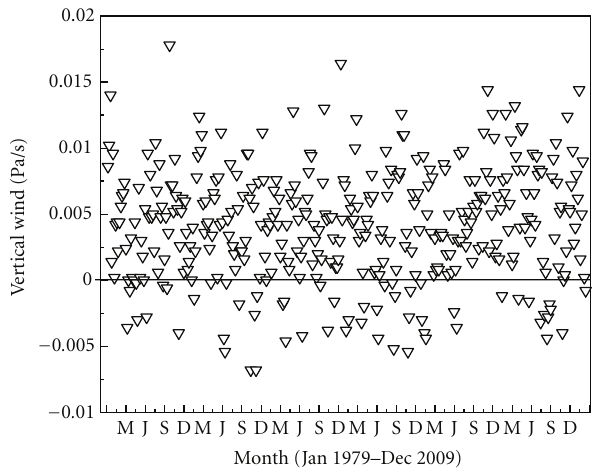
Figure 8: Intercomparison of tropospheric ozone over the NE region using data from simultaneous measurement by TOMS and OMI sensors for the period October 2004–December